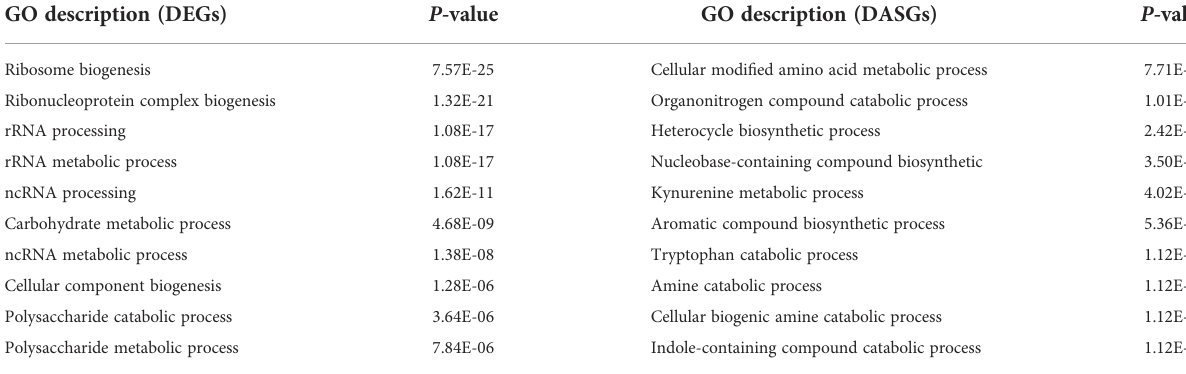
TABLE 1 Top 10 biological processes from the Gene Ontology (GO) enrichment analysis of differentially expressed genes (DEGs) and differential alternative splicing genes (DASGs). GO description